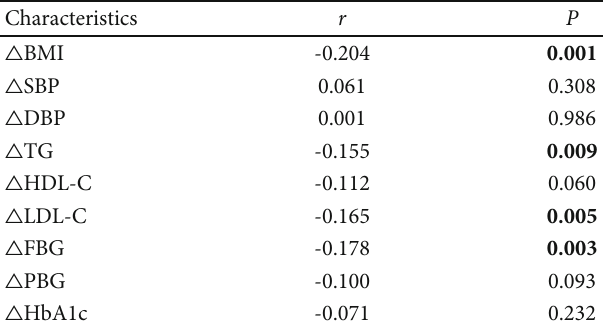
Table 3: Spearman correlation analysis of the △ (metabolic indicators) with △